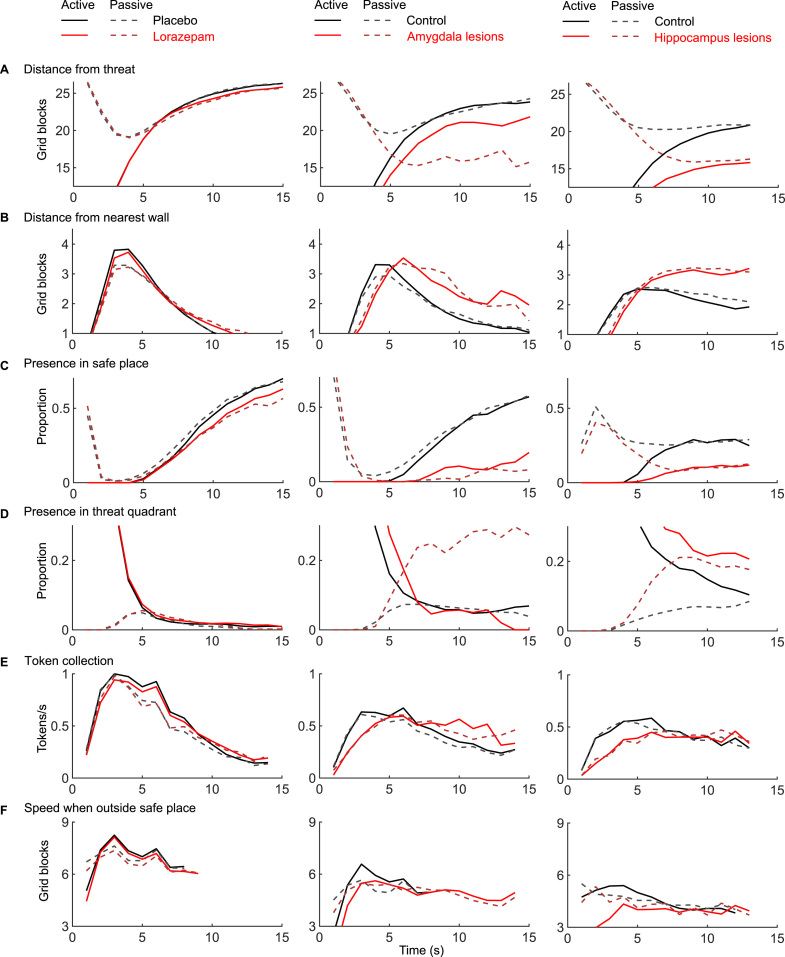
Six secondary metrics of loss adaptation in the approach–avoidance paradigm. Individual metrics show group differences for lorazepam-treated vs. placebo-treated healthy participants as well as for amygdala and hippocampus lesion patients vs. respectively matched controls (see Table 1 for statistical results, Figure 2 for results on the primary outcome measures, and Figure 4 for results on the loss adaptation score that combines the seven measures). In the lorazepam experiment, significant linear interactions of drug × time emerged in four measures (after Bonferroni correction); toward the end of the epoch, participants under lorazepam (compared with those under placebo) were closer to the threatening predator (A), were farther from the nearest wall (B), spent less time in the safe place (C), and collected more tokens (E). Testing patients with amygdala lesions revealed a significant group × time interaction in five measures (after Bonferroni correction); as the epoch progressed, patients with amygdala lesions (compared with controls) were relatively closer to the threatening predator (A) and relatively farther from the nearest wall (B), they spent less time in the safe place (C), collected more tokens (E), and were faster when outside the safe place (F). For presence in the threat quadrant (D), no significant linear interactions of group and time were observed in the lorazepam or amygdala study. See Supplemental Figure S3 for graphs depicting the 2 patients separately. Mean data are plotted for time points in which data from all participants are available (e.g., speed outside the safe place is not shown for some later time points because many participants tend to reside in the safe place toward the end of the epoch).